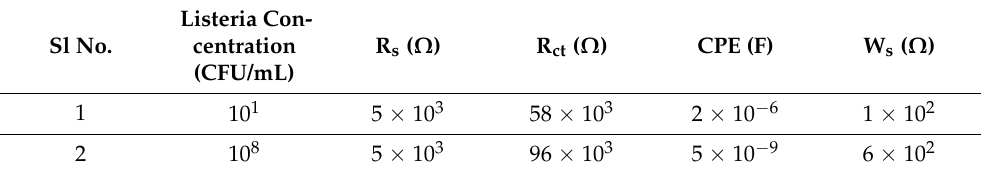
Table 1. A chart highlighting the approximate values of various interfacial parameters modeled by Randel’s circuit using Zview software. Listeria Con- Sl No. centration R s ( Ω ) R ct ( Ω ) CPE (F) W s ( Ω (CFU/mL)